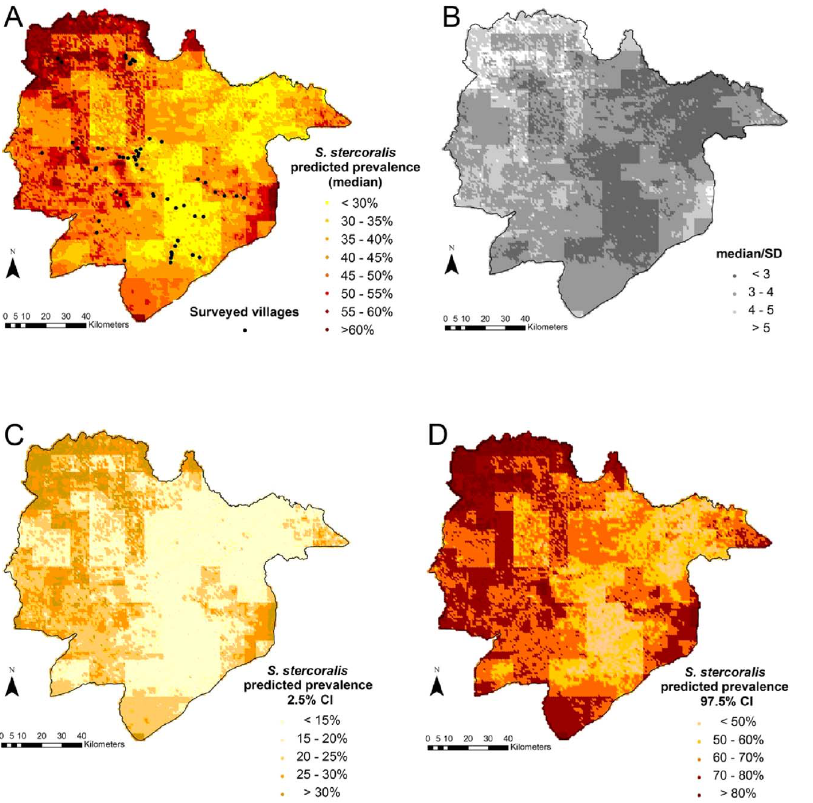
Figure 3. Predicted S.stercoralis median prevalence (a), error coefficient (b); lower (c), and higher (d) estimates of S.stercoralis predicted prevalence in Preah Vihear province, Cambodia. Legend: The error coefficient is the ratio of the predicted median over its standard deviation; a higher value indicates a higher precision. The lower and upper estimates correspond to the 2.5% and 97.5% borders of the Bayesian credible interval,